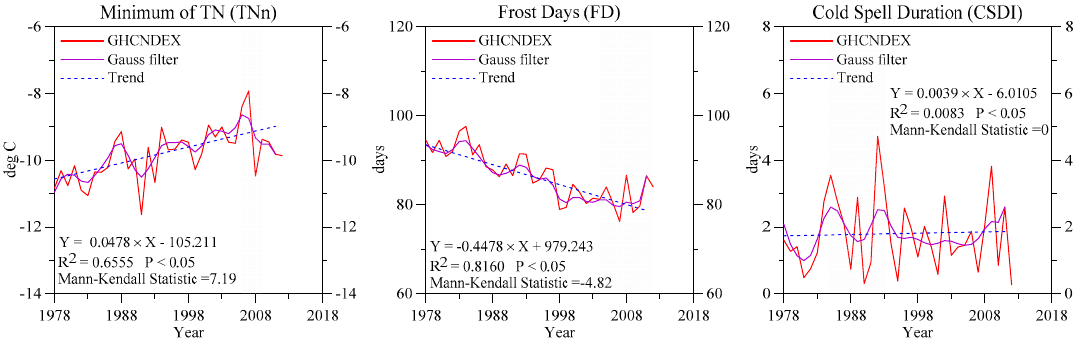
Figure 6. Number of days with the cold spell (( a ) slight risk, ( b ) middle risk, ( c ) high risk, and ( d ) extreme risk) during the period 1979–2017 based on ERA-Interim Reanalysis data.